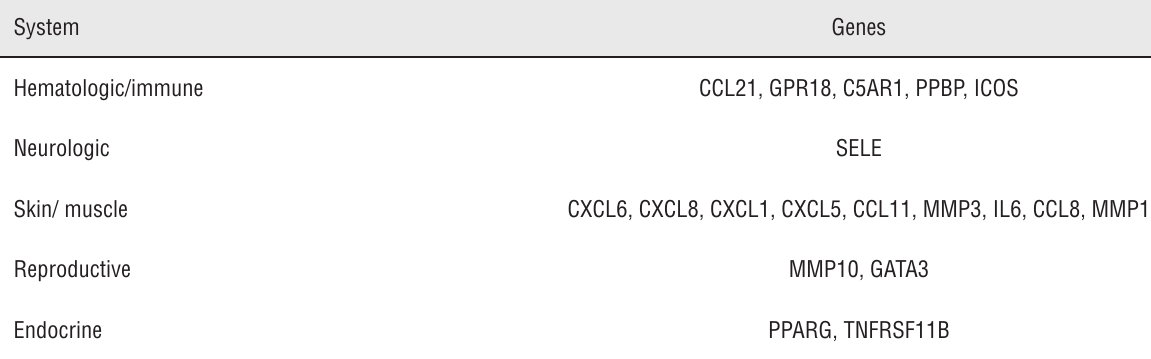
Table 2 - The Tissue-specific expressed genes identified by